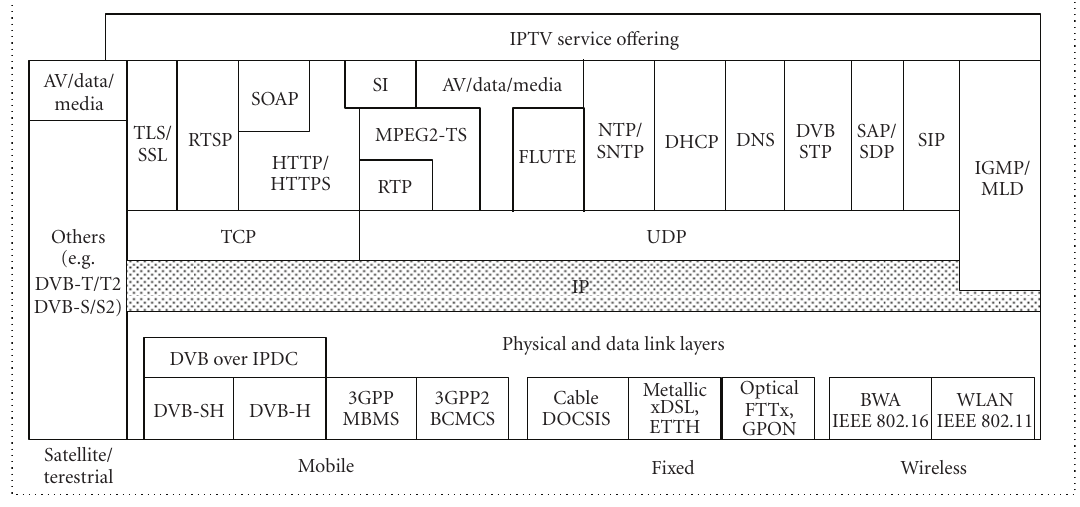
Figure 4: Protocol stack for Converged NGN-based IPTV